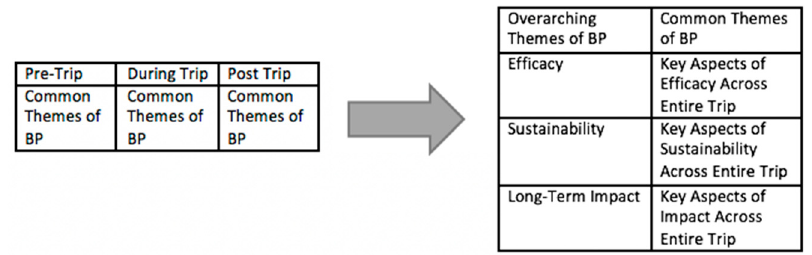
Figure 3. Flowchart diagram of how common Best Practices (BP) themes in literature were sorted into the 3 overarching categories of efficacy, sustainability, and long-term impact.